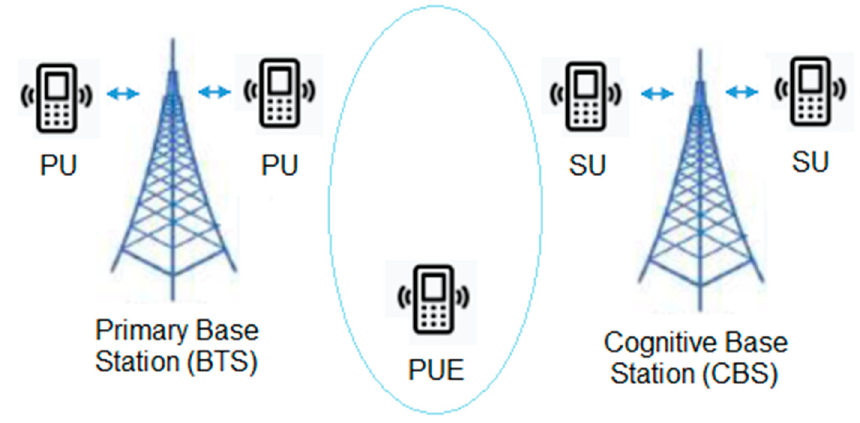
Figure1. Primarynetwork(BTS),mobilecognitiveradionetwork(MCRN)(cognitivebasestation—CBS), Figure 1. Primary network (BTS), mobile cognitive radio network (MCRN) (cognitive base station — users and primary user emulation (PUE) attack. CBS), users and primary user emulation (PUE) attack.